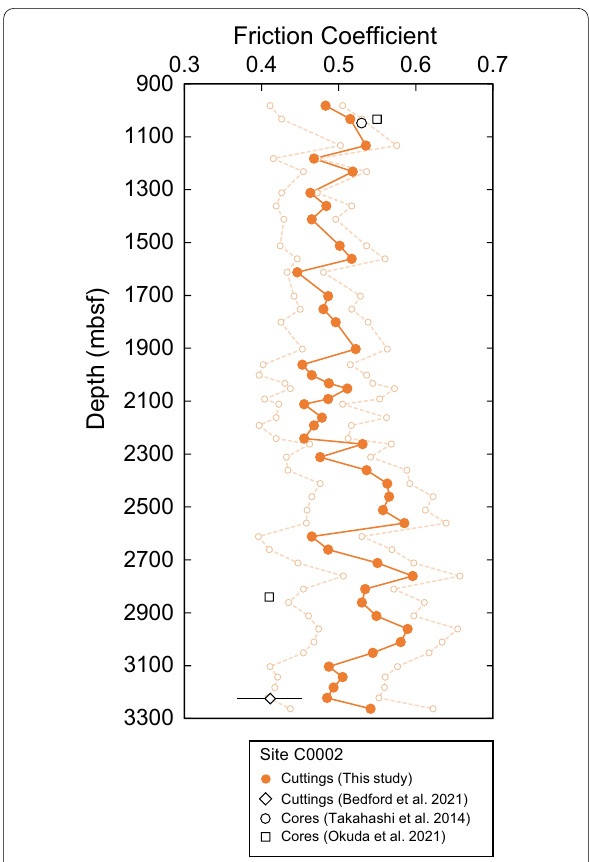
Fig. 5 Depth profile of the friction coefficient obtained via analysis of the cuttings at Site C0002. Friction coefficient obtained at a displacement of 8 mm is shown by orange filled circles, and the lower and upper data (orange open circle) are obtained at displacements of 2 mm and 16 mm, respectively. The black open circles, squares, and diamond indicate data from previous studies at Site C0002 (Takahashi et al. 2014; Okuda et al. 2021; Bedford et al.